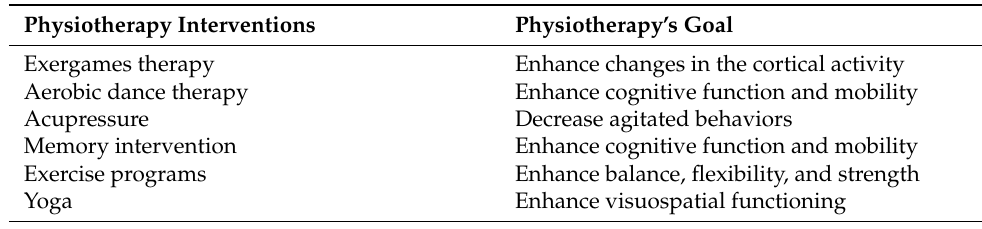
Table 3. Physiotherapy interventions in cognitive impairment and equipment utilized through clinical trials.